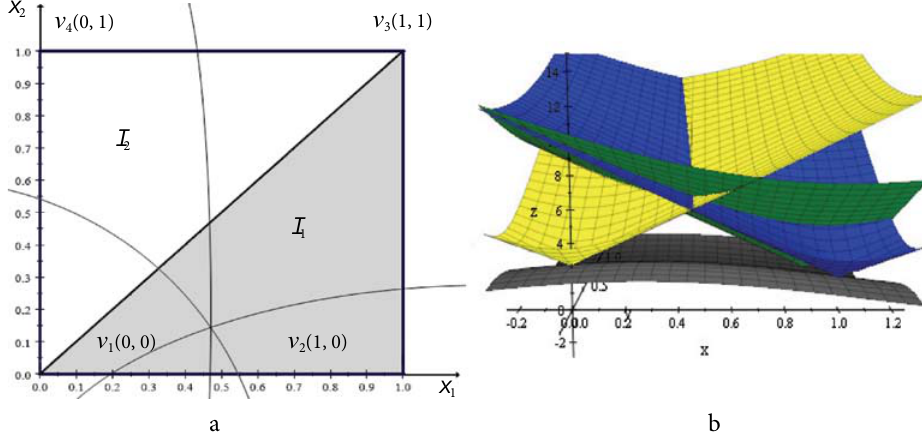
Fig. 2. Projection of intersection curves (a); visualization of upper bounding functions with Euclidean norm